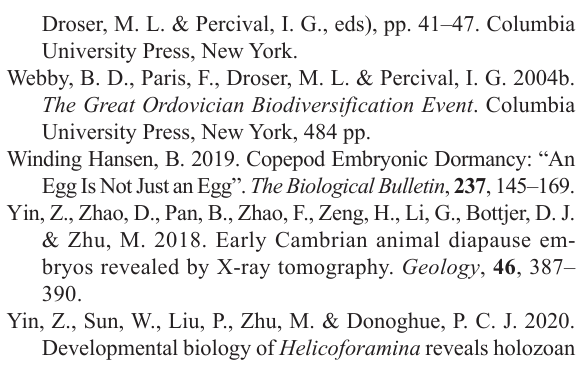
stratigraafiline levik piirdub ainult Kunda lademega. Vikisphaera kesta morfoloogia erineb seni tuntud Ordoviitsiumi mikrofossiilidest, kuid meenutab suuruse ja kesta struktuuri poolest mõnede mereloomade munakapsleid. Töös on püs- titatud hüpotees, et kirjeldatud fossiili bioloogiline funktsioon oli olla kestaks tundmatu päritoluga mittefossiliseeruva selgrootu varasele arengustaadiumile. Seni kuni hüpoteesi kinnitamiseks puuduvad kindlad tõendid, võib Vikisphaera arvata akritarhide hulka, mis vastavalt definitsioonile hõlmavad kõiki tundmatu päritoluga orgaanilise kestaga mikro-